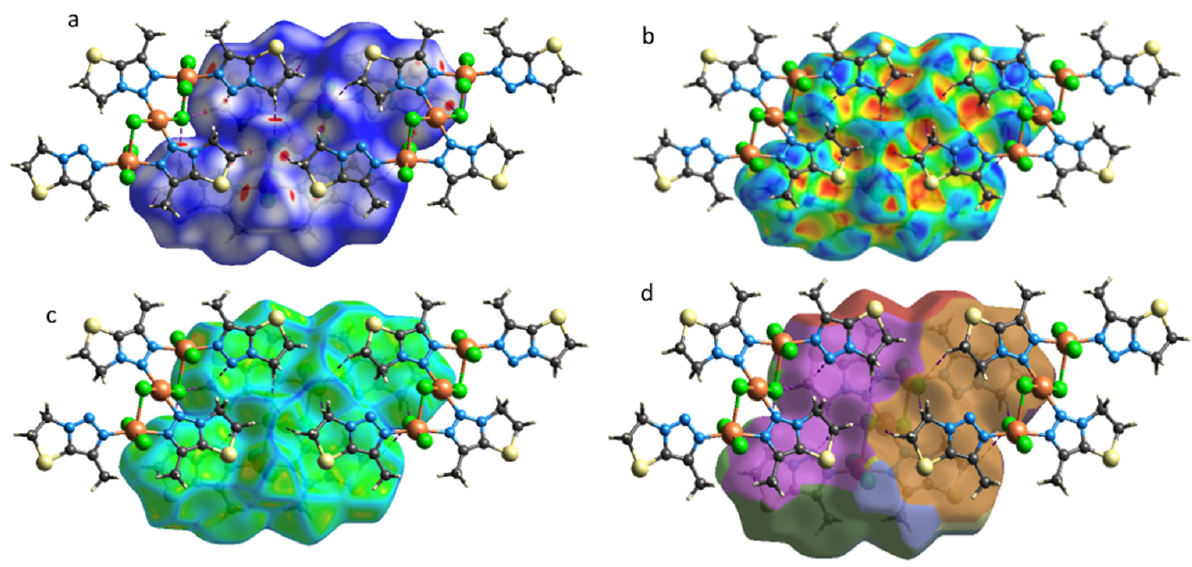
Figure 4. Hirshfeld surfaces mapped with ( a ) d norm , ( b ) shape index, ( c ) curvedness, and ( d ) fragment patch of the copper complex.